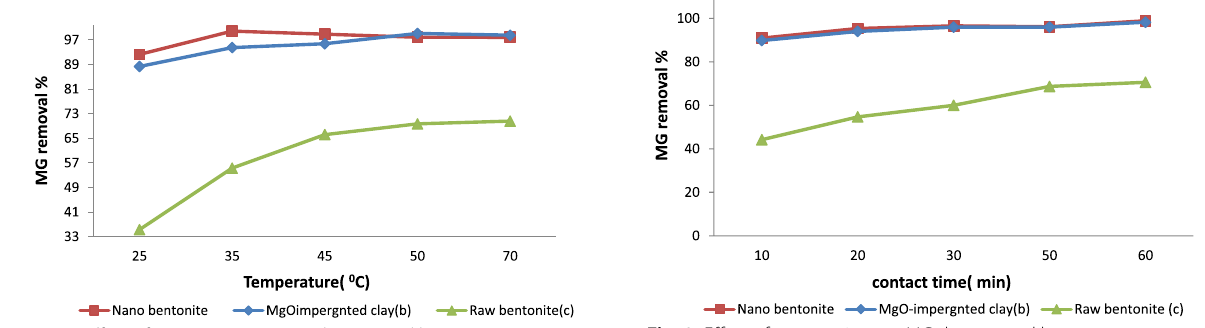
Fig. 7 Effect of temperature on MG dye removal by a nano-bentonite, b MgO impregnated clay and c raw bentonite